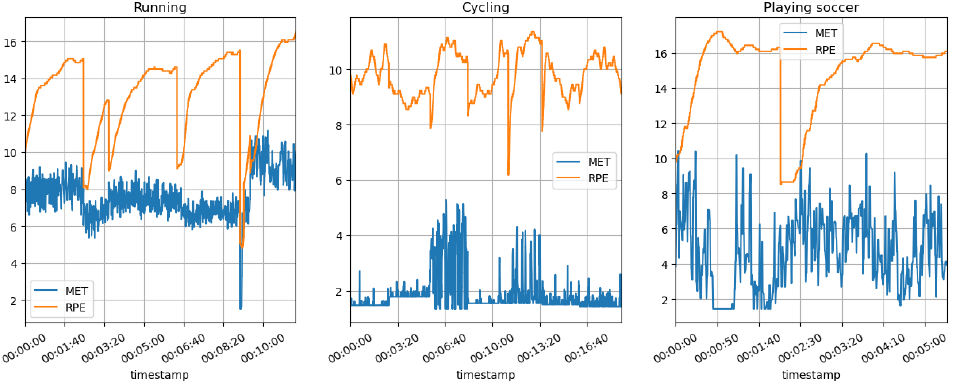
Figure 8. MET and RPE per